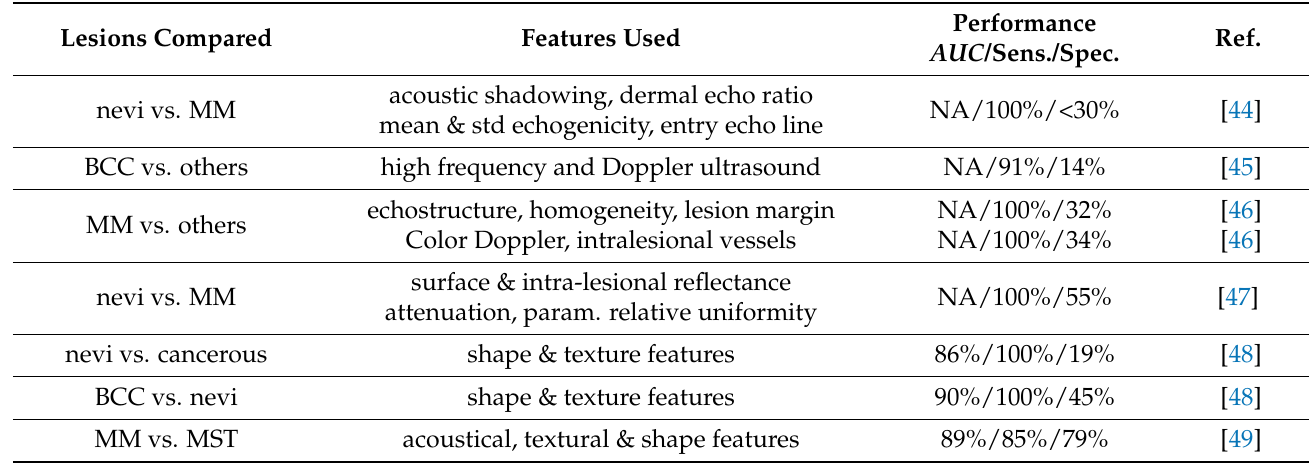
Table 1. Comparison of ultrasound-based skin lesion differential diagnosis methods focusing on benign and malignant skin lesion. In contrast to the current proposed method, none of the methods are fully automated since they do not employ fully-automated (FA) segmentation. NA stands for Not